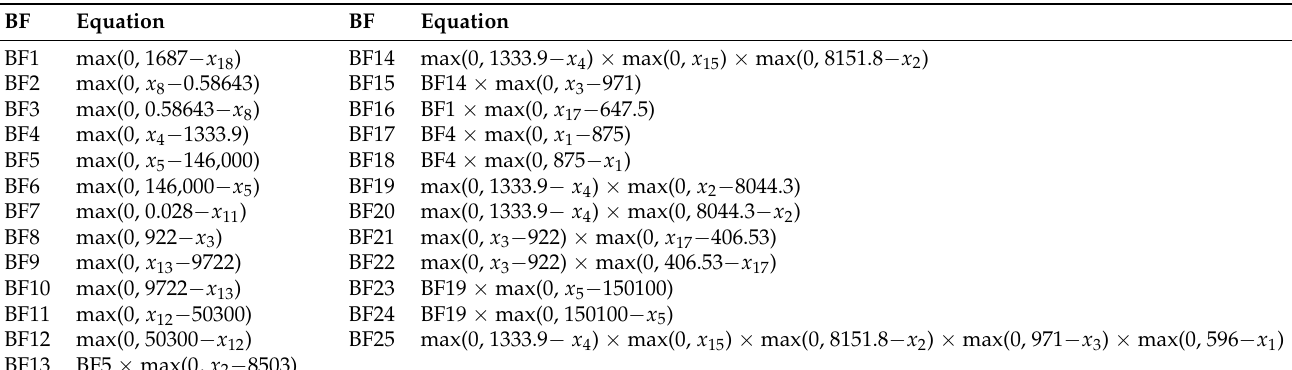
Table 13. Basis functions of the piecewise-linear MARS model of carbon content (lime and dolomitic lime added as supplementary